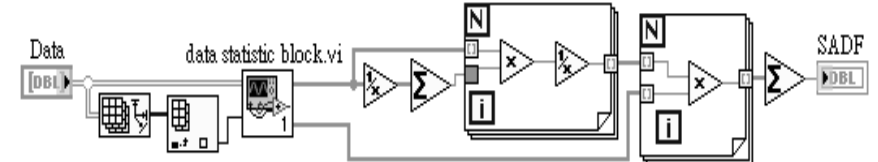
Figure 6. LabVIEW block diagram of self-adaptive data fusion used for RuO sensor